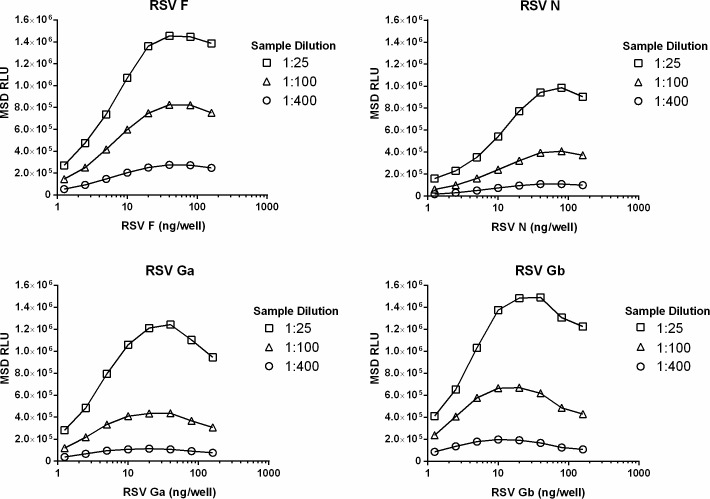
Representative example of an antigen titration experiment to determine optimal coating density.For each antigen, a stock solution was serially diluted and coated onto 96-well MSD plates. In this example, three dilutions of the assay control (MN log2 IC50 titer = 9.9) were tested at a fixed concentration of goat anti-human IgG SULFO-TAG antibody (0.5 ug/ml). Symbols represent mean values from eight replicates.